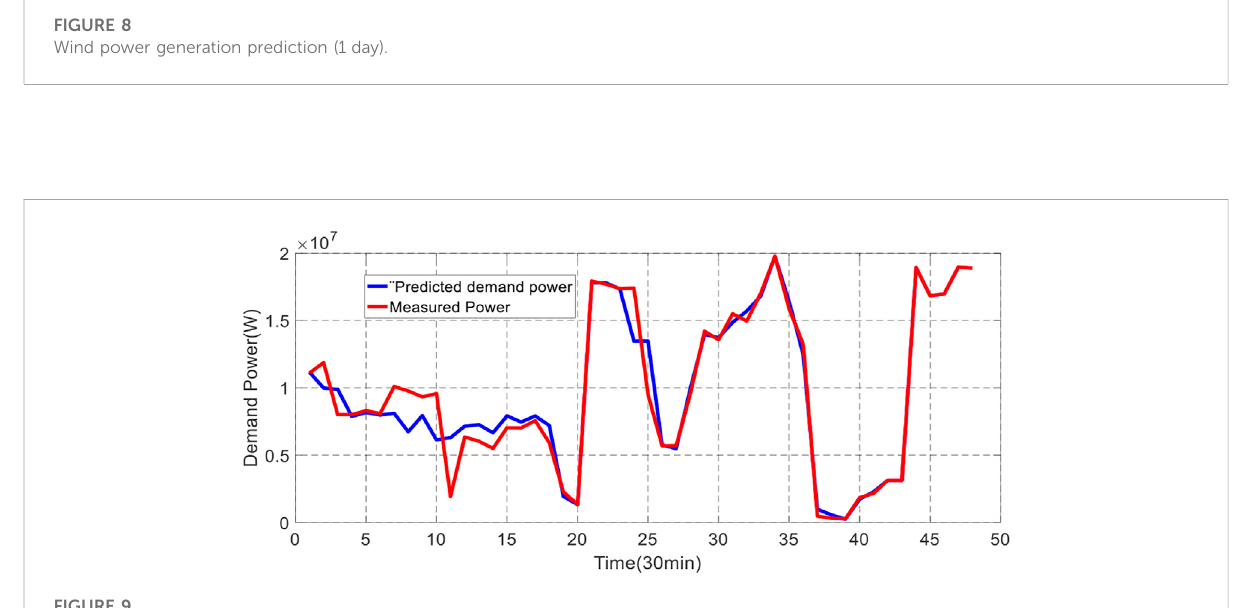
FIGURE 9 Load demand prediction (1 day).